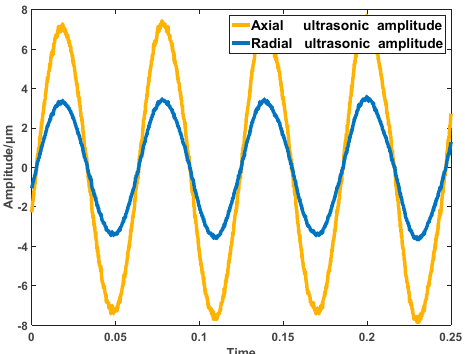
Figure 6. Axial and radial ultrasonic synchronization effects.